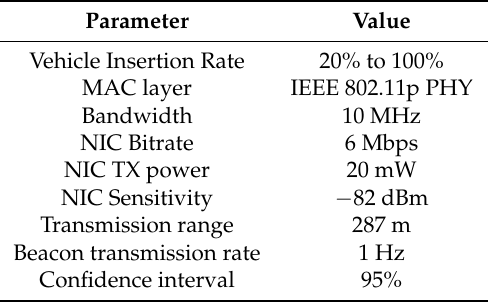
Table 2. Simulation parameters